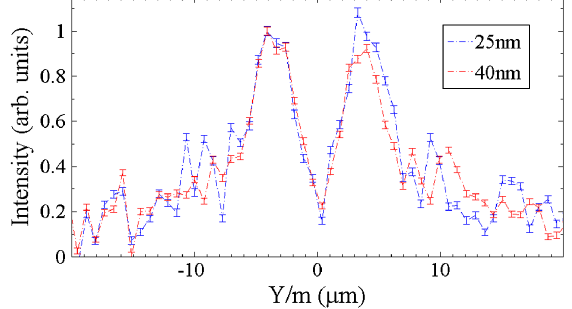
FIG. 14. OTR PSF measured for an achromatic lens with 550 nm optical filters of 25 and 40 nm bandwidth.